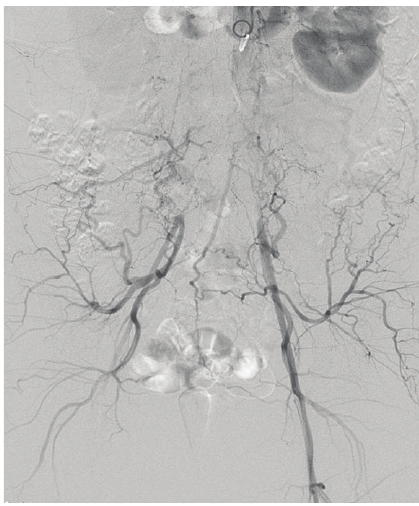
Figure 2: Aortogram showing reconstitution at the level of the iliac bifurcations.